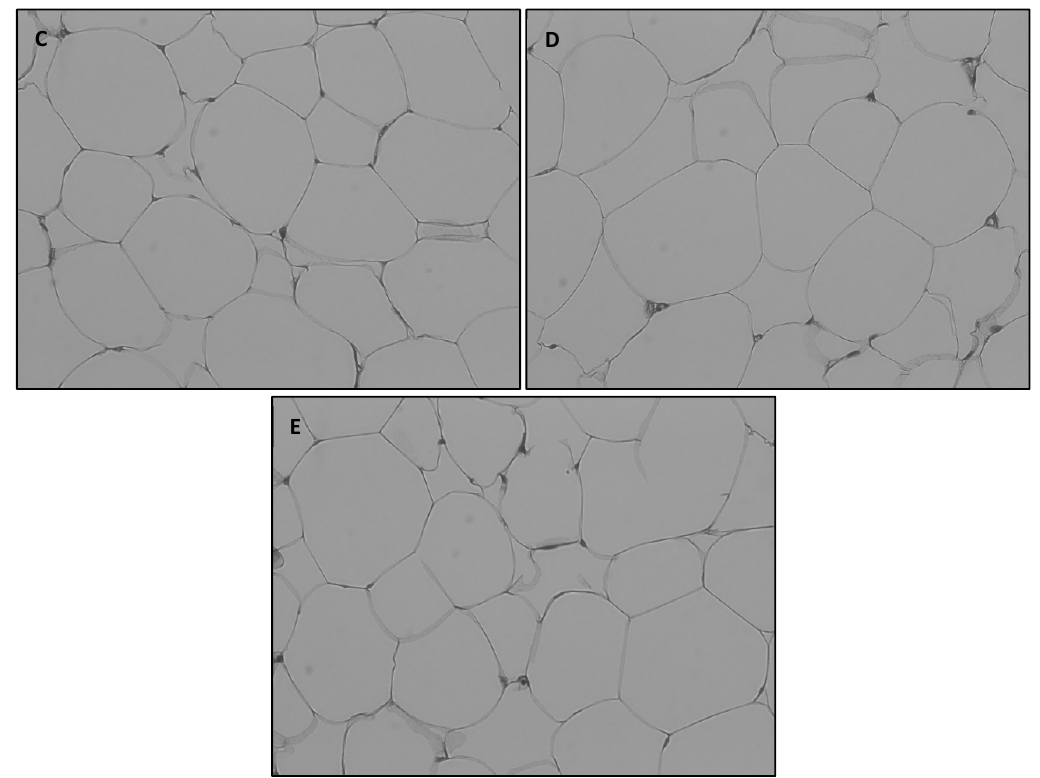
Figure 2. Representative hematoxylin and eosin staining of omental adipose tissue (OMAT) in SD rats exposed to experimental diet for 8 weeks (original magnification, × 200).